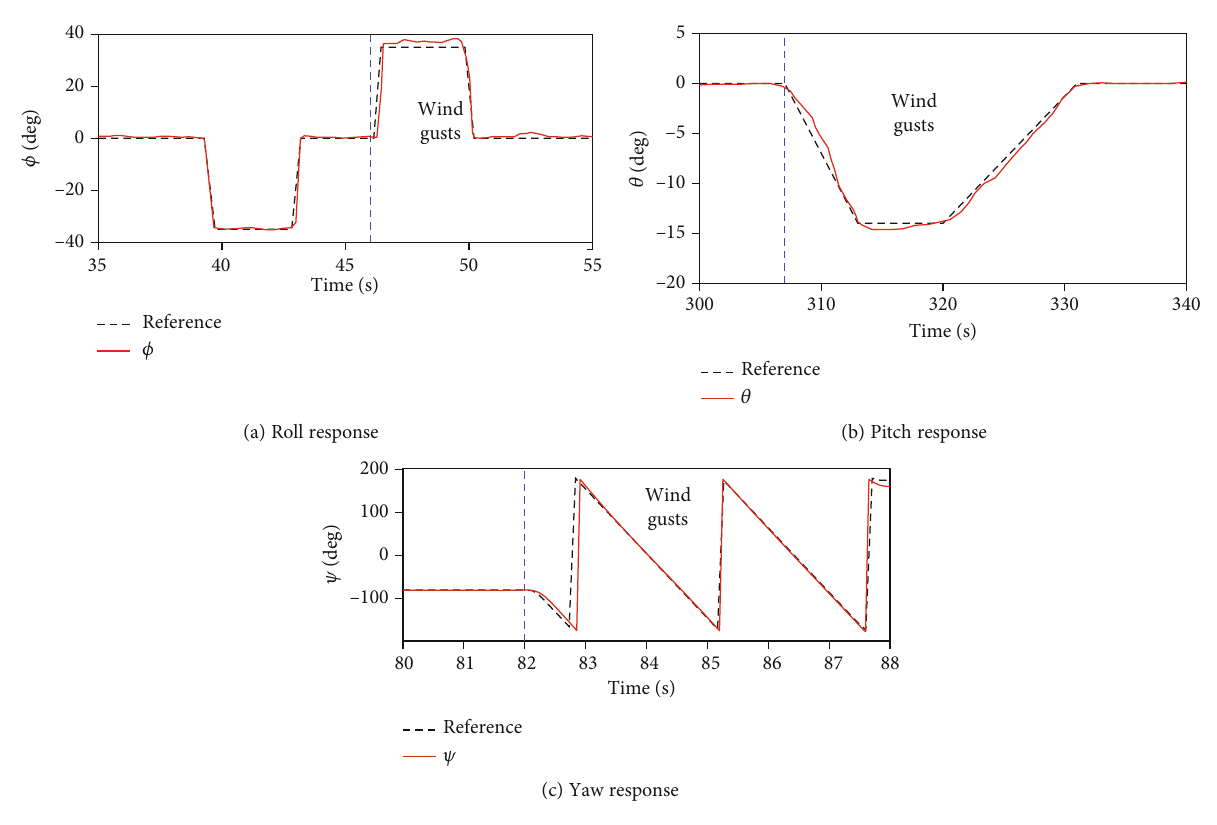
Figure 15: Attitude tracking in the